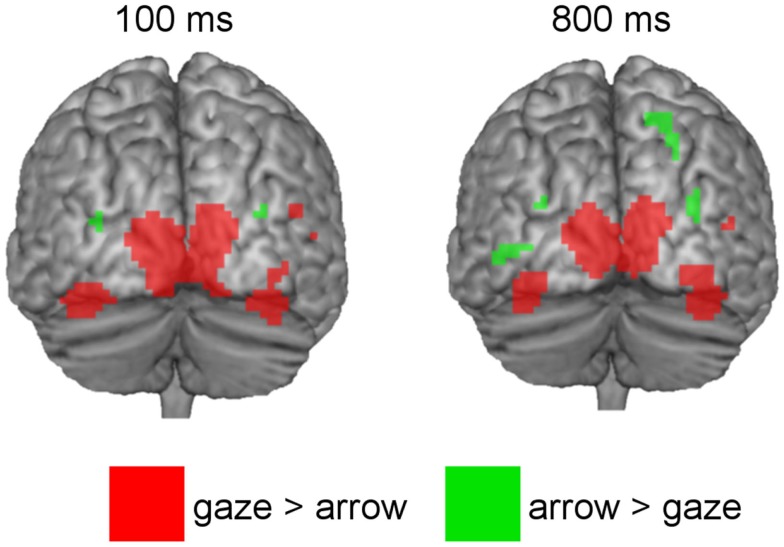
Above threshold activations of brain regions showing greater BOLD-responses to directional gaze versus directional arrow cues (red) and to directional arrow versus directional gaze cues (green) at 100 and 800 ms SOA.